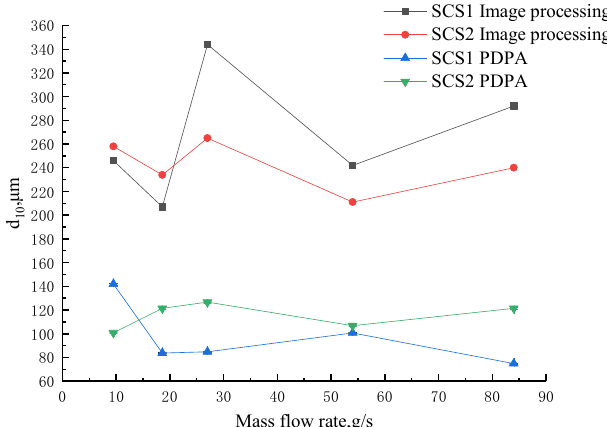
Figure 6. Average length diameters d 10 of the atomization field under different mass flow rates.